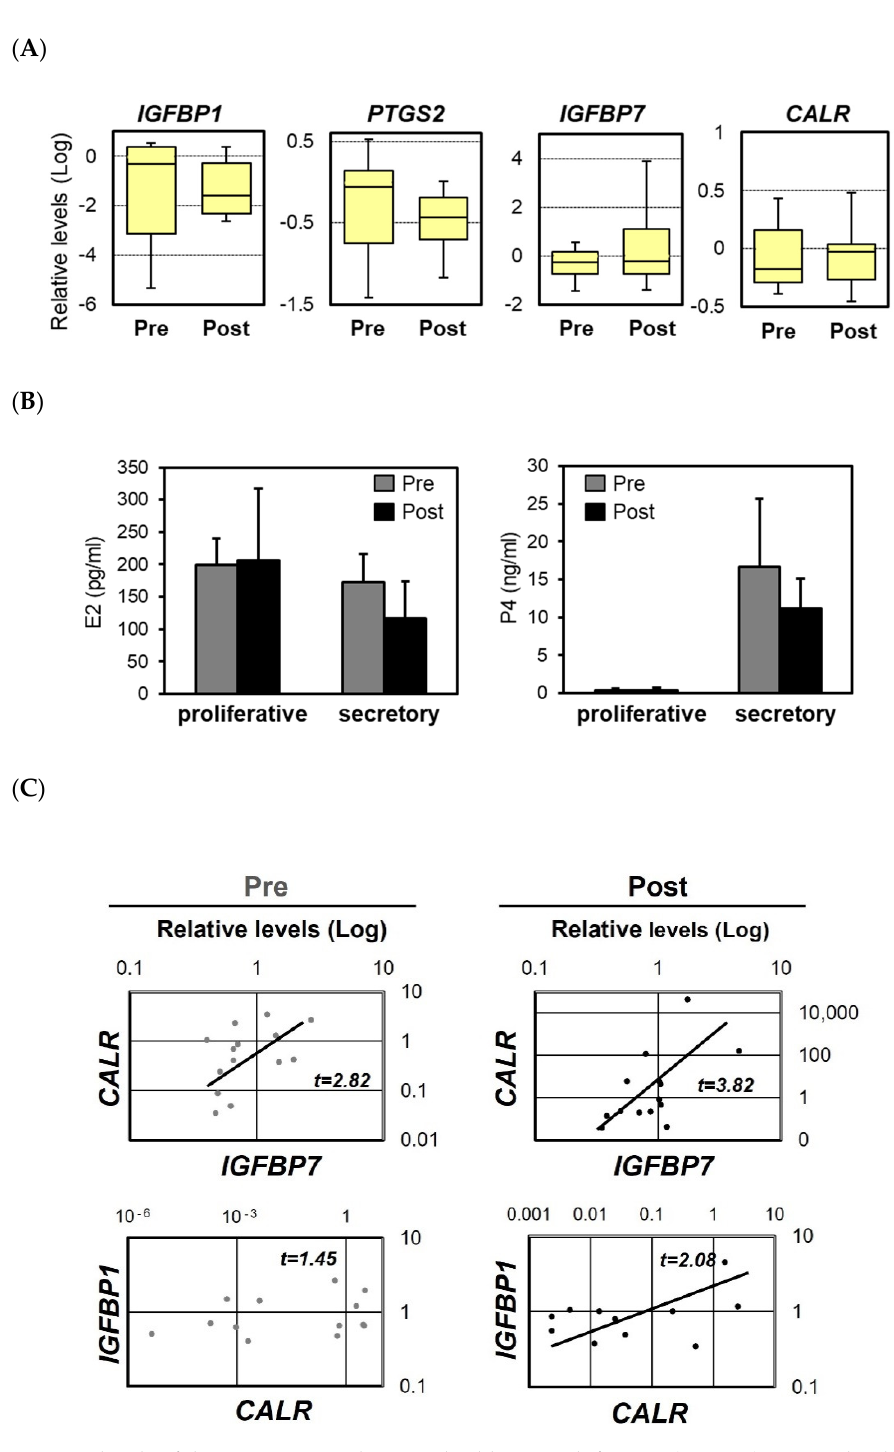
Figure 5. The expression levels of the mRNAs encoding insulin-like growth factor 1 (IGFBP1), prostaglandin G/H synthase 2 (PTGS2), IGFBP7, and calreticulin (CALR) in infertile patients before and after polypectomy. The expression levels of the IGFBP1 , PTGS2, IGFBP7, and CALR mRNAs in the human endometrium before and after polypectomy ( A ). The scales indicate the relative expression levels of each mRNA. The bottom and top of each box indicate the 25th and 75th percentiles, respectively, and the band in the middle of the box indicates the median value (of 27 patients). The concentrations of estradiol-17 β (E2) and progesterone (P4) in serum during the proliferative and secretory phases of the uterine cycle, as measured using electrochemiluminescence immunoassay ( B ). Samples were collected before and after polypectomy. Data represent the mean ± SEM of 27 patients. Correlations between the mRNA expression levels of CALR and IGFBP1 or IGFBP7 in the endometrium of infertile patients before and after polypectomy ( C ). Relative mRNA expression levels were detected by real-time